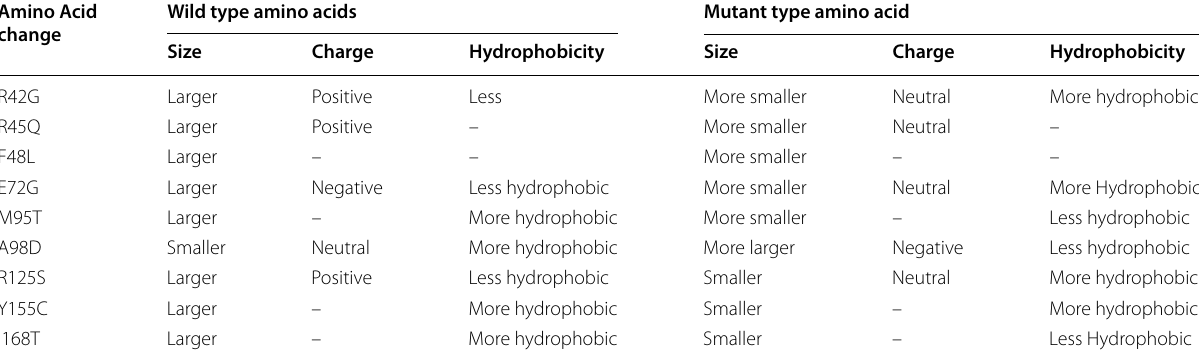
Table 4 Results of wild-type and mutant-type amino acid properties obtained from Project Hope software Amino Acid